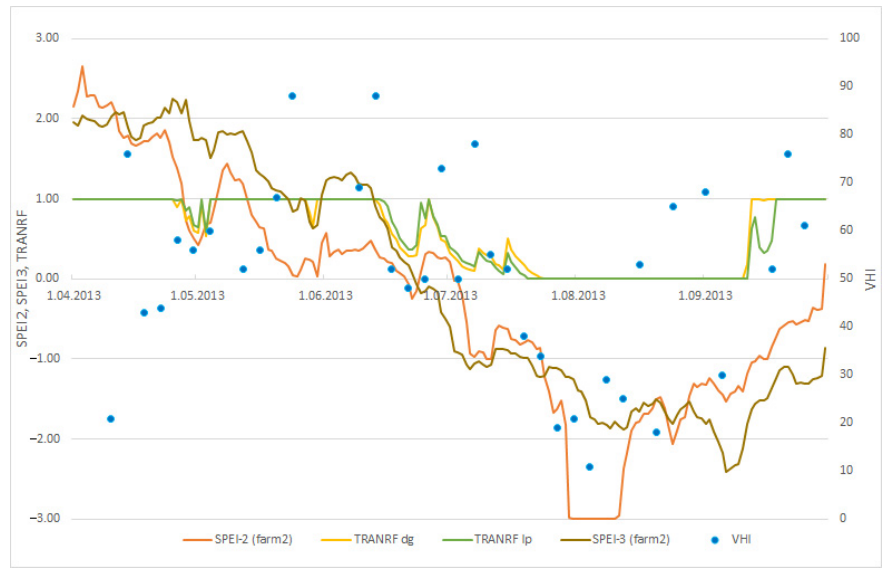
Figure 8. Time series of the LINGRA-N model results of drought factor (TRANRF) using the pa- rameter set calibrated for Dactylis glomerata in Jablje (dg) and Lolium perenne in Jablje (lp); time series of drought indices (VHI, SPEI-2, and SPEI-3) for Farm2, all for 2013.